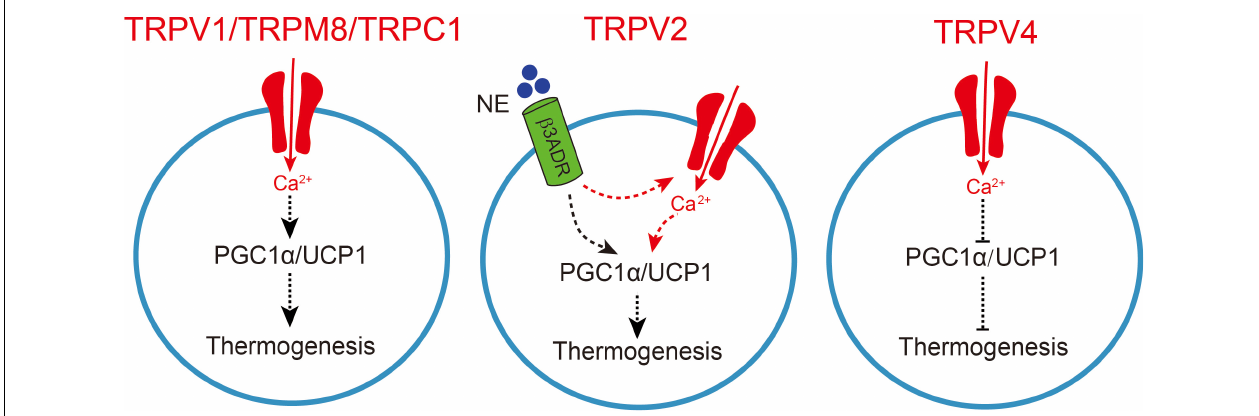
FIGURE 1 | TRP channel-mediated adipocyte thermogenesis. A schematic figure of how TRPV1, TRPV2, TRPV4, TRPM8, and TRPC1-mediated calcium influx regulates thermogenic gene expression in adipocytes, which causes enhanced thermogenesis. Moreover, the increase in sympathetic nerve activity causes norepinephrine release from the sympathetic nerves and activation of β 3-adrenergic receptor ( β 3ADR) in brown adipocytes, TRPV2 synergistically collaborated with β 3ADR to involve in the regulation of peroxisome proliferator-activated receptor gamma coactivator-1 a (PGC1a) and uncoupling protein 1 (UCP1),